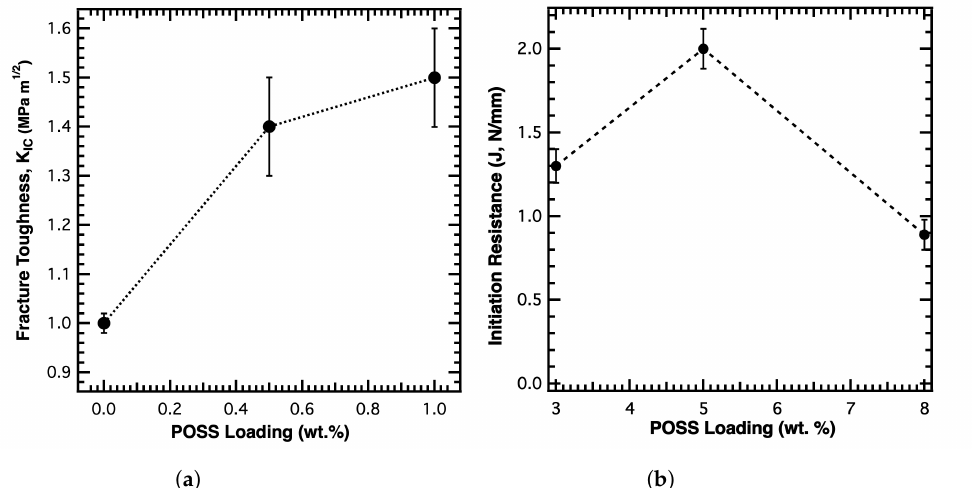
Figure 6. Fracture and initiation toughness of brittle POSS–epoxy nanocomposite compared to ductile POSS–epoxy nanocomposite. ( a ) Fracture toughness of neat resin and POSS–epoxy nanocomposites (0–1 wt.% POSS inclusion) in term of critical stress intensity factor. ( b ) Initiation fracture toughness of POSS–epoxy nanocomposites at higher loading of POSS. Table 1. Fracture Properties of brittle and ductile POSS–epoxy nanocomposites. POSS